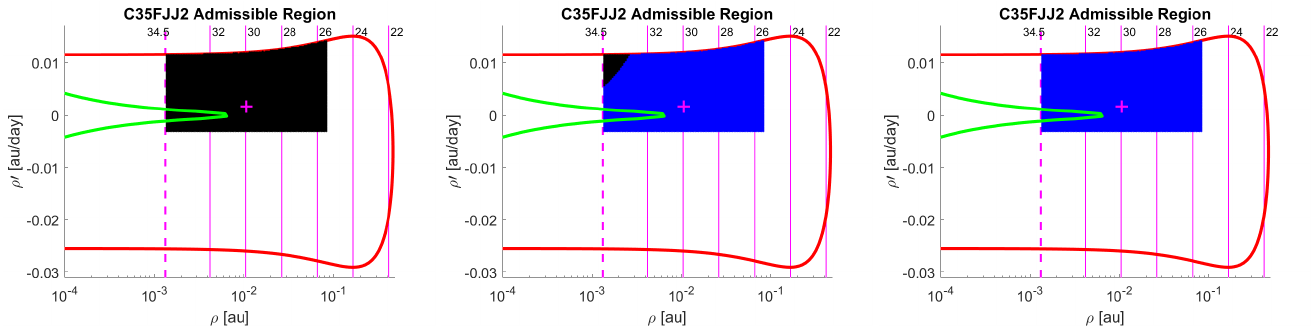
Figure 12. EoV for asteroid C35FJJ2 from three different observatories located in Arizona. From left to right: 699 Lowell Observatory, G96 Mount Lemmon Observatory, V06 Steward Observatory.